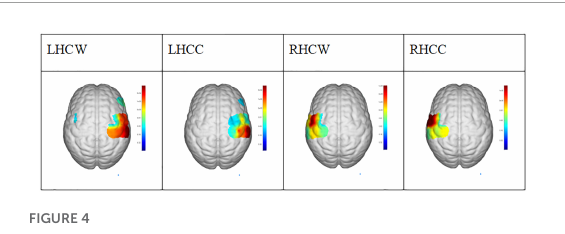
FIGURE4 The activation region ( t = 0.05) under general linear model in conditions of LHCW, LHCC, RHCW, and RHCC. LHCW, left hand clockwise. LHCC, left hand counterclockwise. RHCW, right hand clockwise. RHCC, right hand